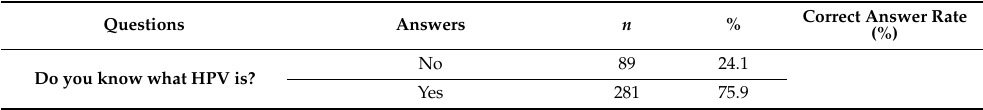
Table 3. Rate of answers to the questions pertaining to HPV knowledge. Correct answers have been marked in